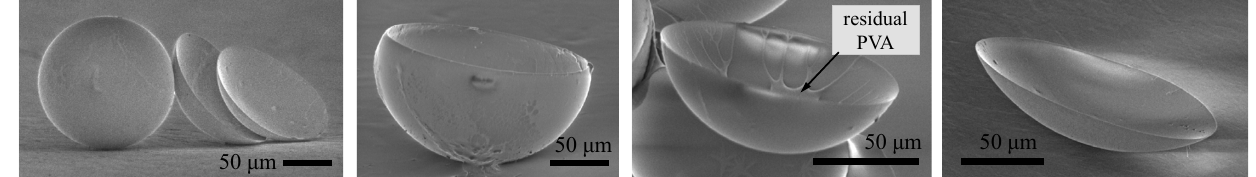
Figure 8. Various shapes of capsules, bowl-like and lens-like, resulting from different solidification